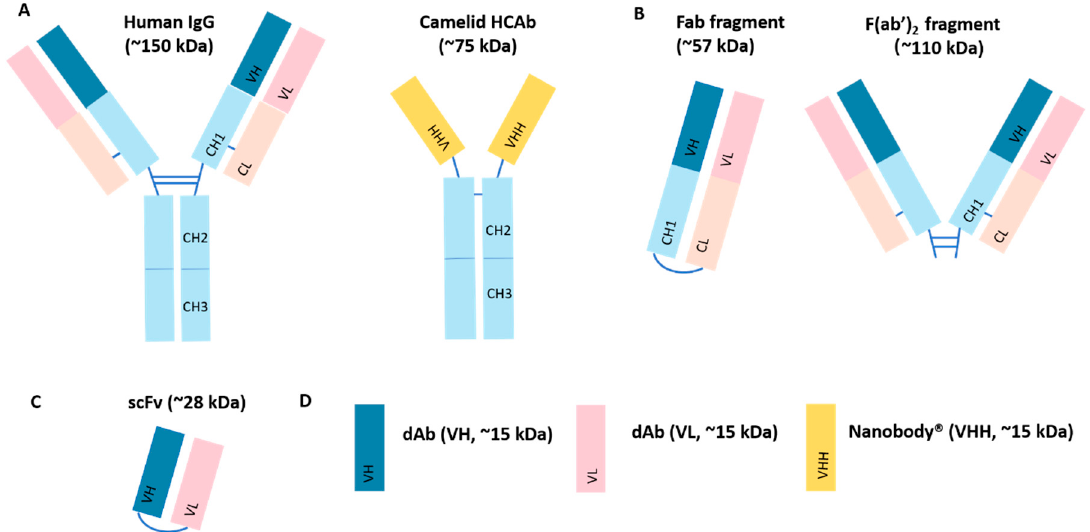
Figure 3. Schematic representation of di ff erent antibody fragments investigated for pulmonary delivery. ( A ) Conventional antibodies from mammals have Y-shape structure composed of two identical heavy and light chains. Each chain contains constant regions (CH1, CH2, CH3 and CL) and variable regions (VH and VL) that are held together by disulfide bonds. Members of the Camelidae family naturally produce a unique type of immunoglobulin that is devoid of light chains. These heavy chain-only antibodies (HCAbs) are formed by a single variable domain (VHH) and two constant domains; ( B ) Fab is an antibody fragment that can bind to antigens without Fc region; F(ab’)2 contains two Fab fragments linked together by disulfide bonds; ( C ) Single-chain fragment variable (scFv) is composed of variable domains of the heavy (VH) and light chains (VL) of human IgG, connected by a peptide linker; ( D ) Domain antibodies (dAbs) are antibody fragments derived from the variable domains of either the heavy or light chain of human IgG. Nanobody ® is the recombinant single-domain antibody derived from the HCAbs of Camelidae.